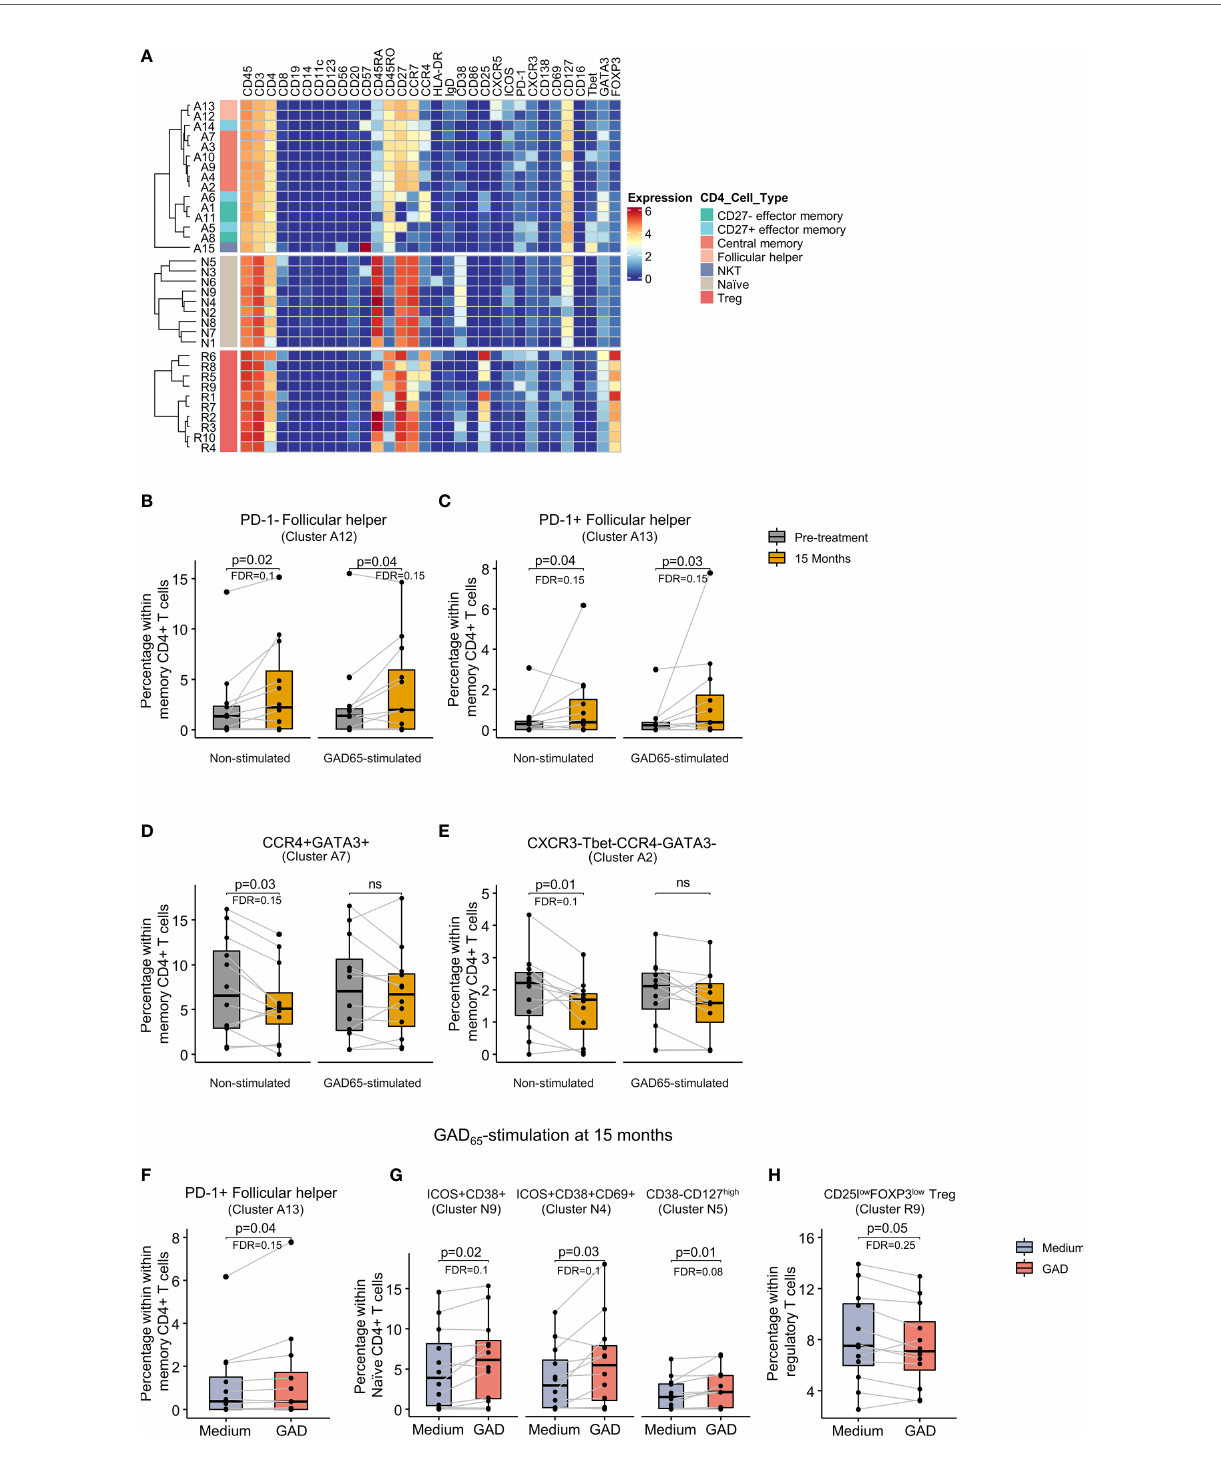
FIGURE 4 | Identi fi cation of CD4+ T cellclustersand changes after GAD-alum therapy. (A) Heatmap showingmedian marker expression across the 15 clusters identi fi ed within memoryCD4+ T cells, the 9 clustersidenti fi edwithin naïveCD4+ T cells and the 10 clustersidenti fi ed within regulatory T cells. Proportion of (B) PD-1-follicular helper T cells (cluster A12), (C) PD-1+ follicular helper T cells (cluster A13), (D) CCR4+GATA+ (cluster A7)and (E) CXCR3- Tbet-CCR4-GATA3- cells (cluster A2)before (grey)and after treatment (yellow)in non-stimulated andGAD 65 -stimulated samples. Proportion after 15 months of treatment of (F) PD-1+ follicular helper T cells (cluster A13), (G) ICOS +CD38+CD69- (cluster N9), ICOS+CD38 +CD69+ (cluster N4), andCD38-CD127 high (cluster N5)naïve CD4+ T cells, and (H) CD25 low FOXP3 low within regulatory T cells (cluster R9) in PBMCs cultured in medium alone or in the presence of 5 m g/ml of GAD 65 for 72 hours. Dots represent individualsand boxplots indicate median and interquartile range. Wilcoxonsigned-rank test. p < 0.05 was consideredsigni fi cant. FDR,False discovery rate (Benjamini – Hochberg).ns: nonsigni fi